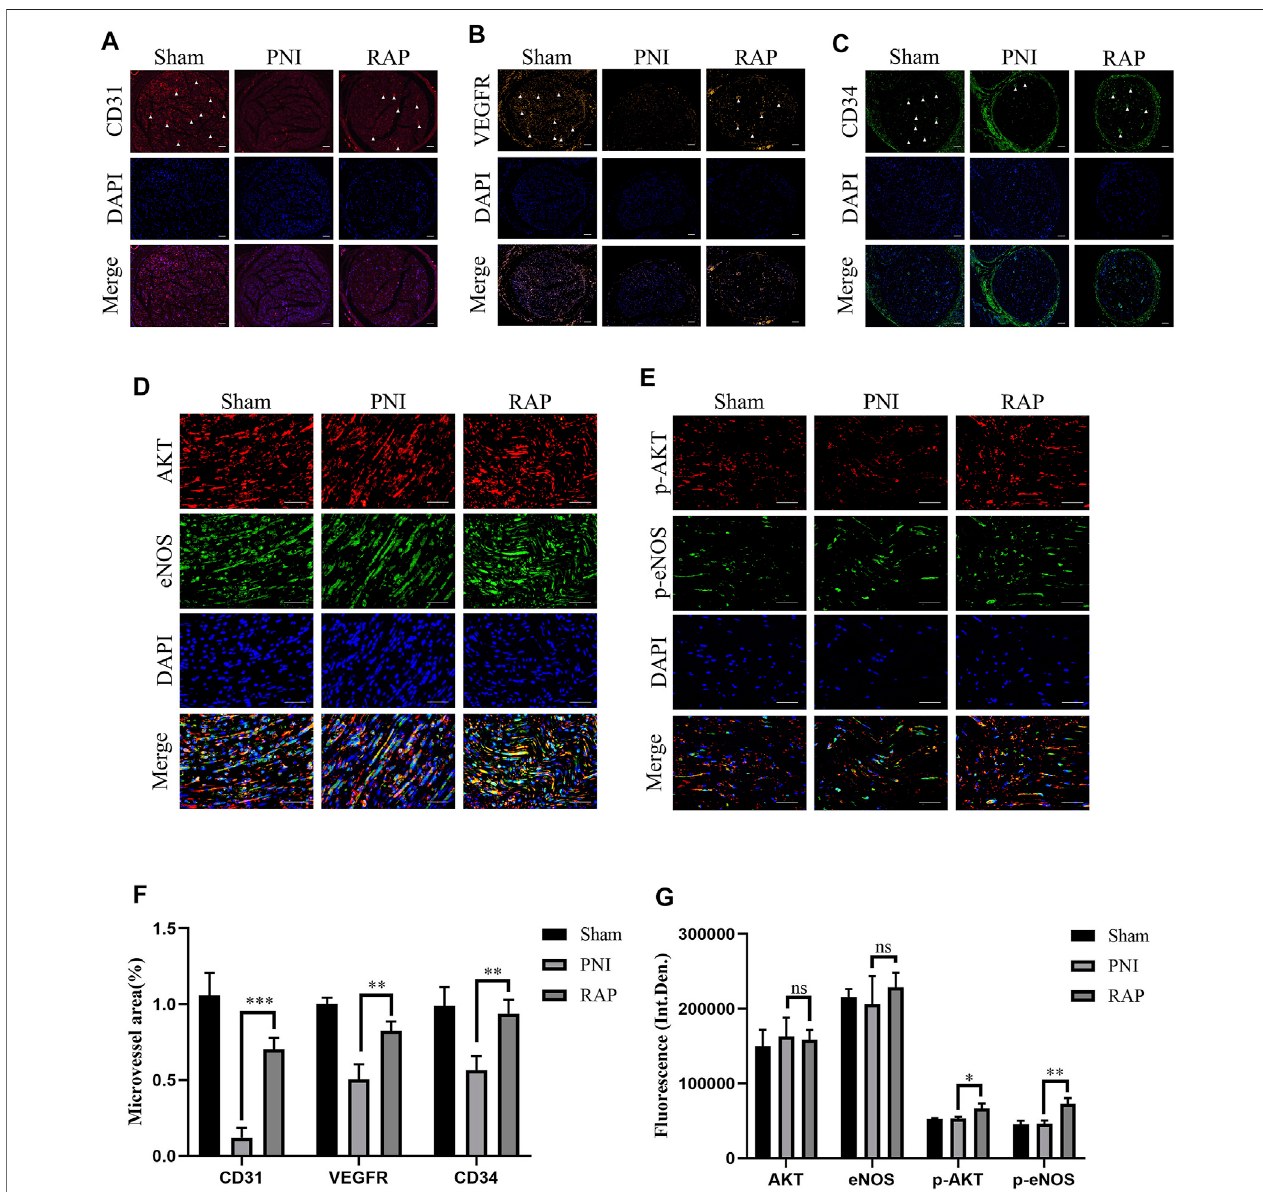
FIGURE 8 | RAP Accelerated Angiogenesis of the Sciatic Nerve through activation of the AKT/eNOS signaling pathway (A – C) Representative images of immuno fl uorescence stainingfor CD31(red), VEGFR(orange), CD34(green) ofsciatic nervetransverse sections ineach group 28days after PNI. Nuclei arestained with DAPI(blue)(100×ampli fi cation,scalebar=100 μ m),arrowsshowneovascularization; (D) Representativeimagesofdoubleimmuno fl uorescenceco-localizationstaining for AKT (red) and eNOS (green) of sciatic nerve longitudinal sections in each group 28 days after PNI. Nuclei are stained with DAPI (blue) (400× ampli fi cation, scale bar = 50 μ m); (E) Representativeimages ofdoubleimmuno fl uorescence stainingforp-AKT(red) and p-eNOS (green) ofsciatic nerve longitudinalsections in each group 28 days after PNI. Nuclei are stained with DAPI (blue) (400× ampli fi cation, scale bar = 50 μ m) (F) Statistical analysis of Microvessel area (G) Statistical analysis of fl uorescence integrated density of AKT, eNOS, p-AKT, and p-eNOS. Data are presented as means ± SD. * p < 0.05**, p < 0.001,*** p < 0.0005.